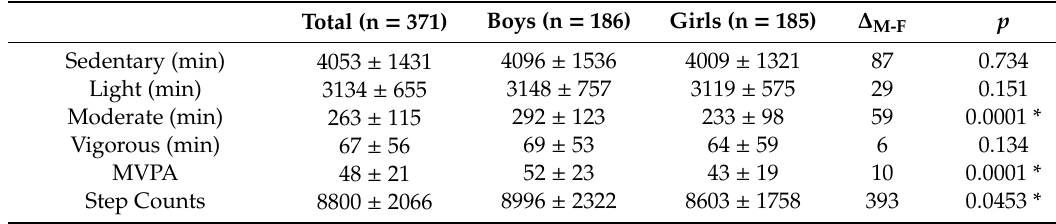
Table 2. Physical activity by